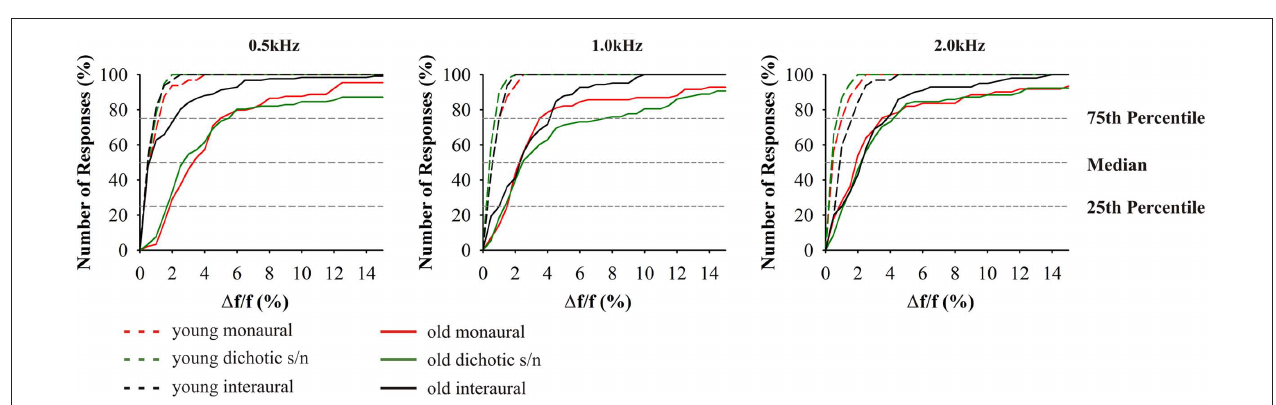
FIgure 4 | Cumulative distributions of JND of intensity discrimination. From left to right results for the test frequencies 0.5, 1.0, and 2.0 kHz. Red indicates: monaural stimulation of either ear; green: dichotic signal/noise stimulation; black: stimulation with interaural signal differences. The different age groups are indicated by the different line types: 20–29 ( n = 16) long dashed lines,